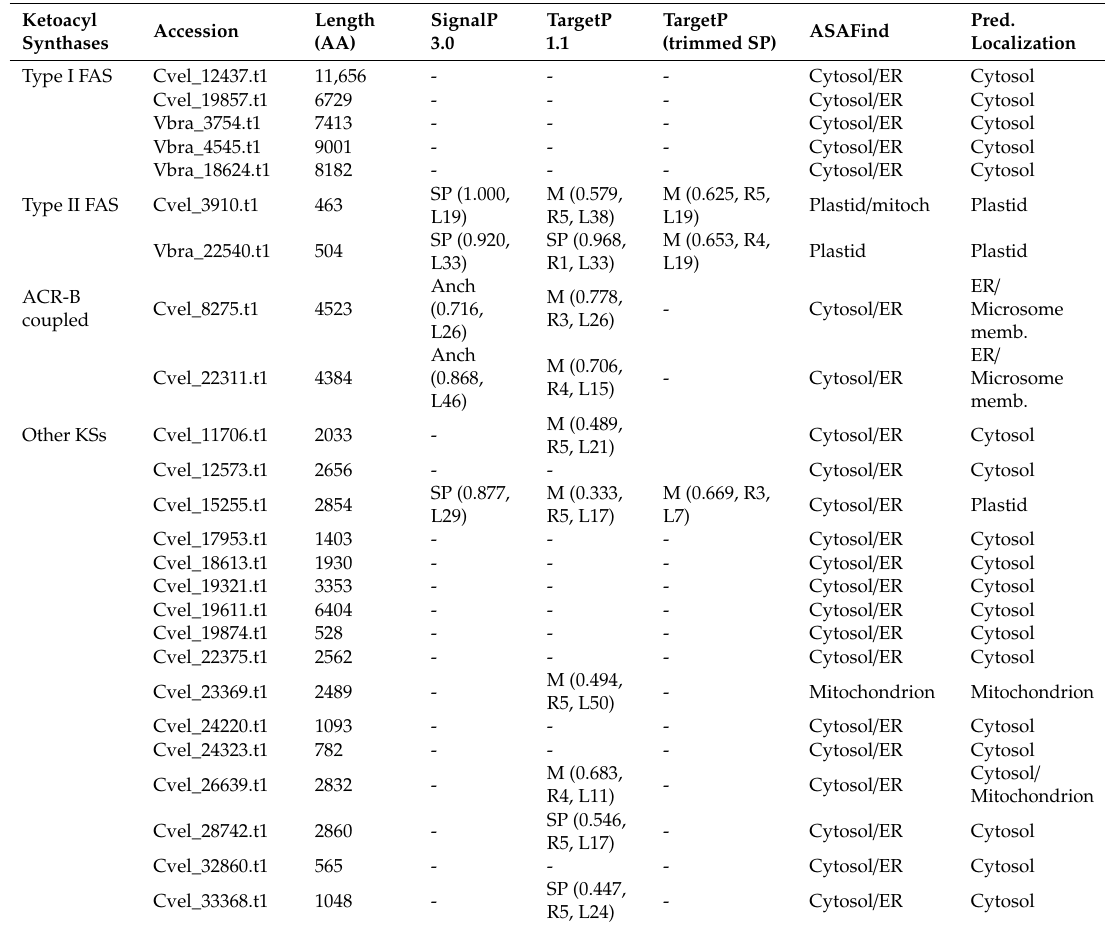
Table 1. Ketoacyl synthases (KSs), elongases, and desaturases in chromerids and their predicted subcellular location. ER—endoplasmic